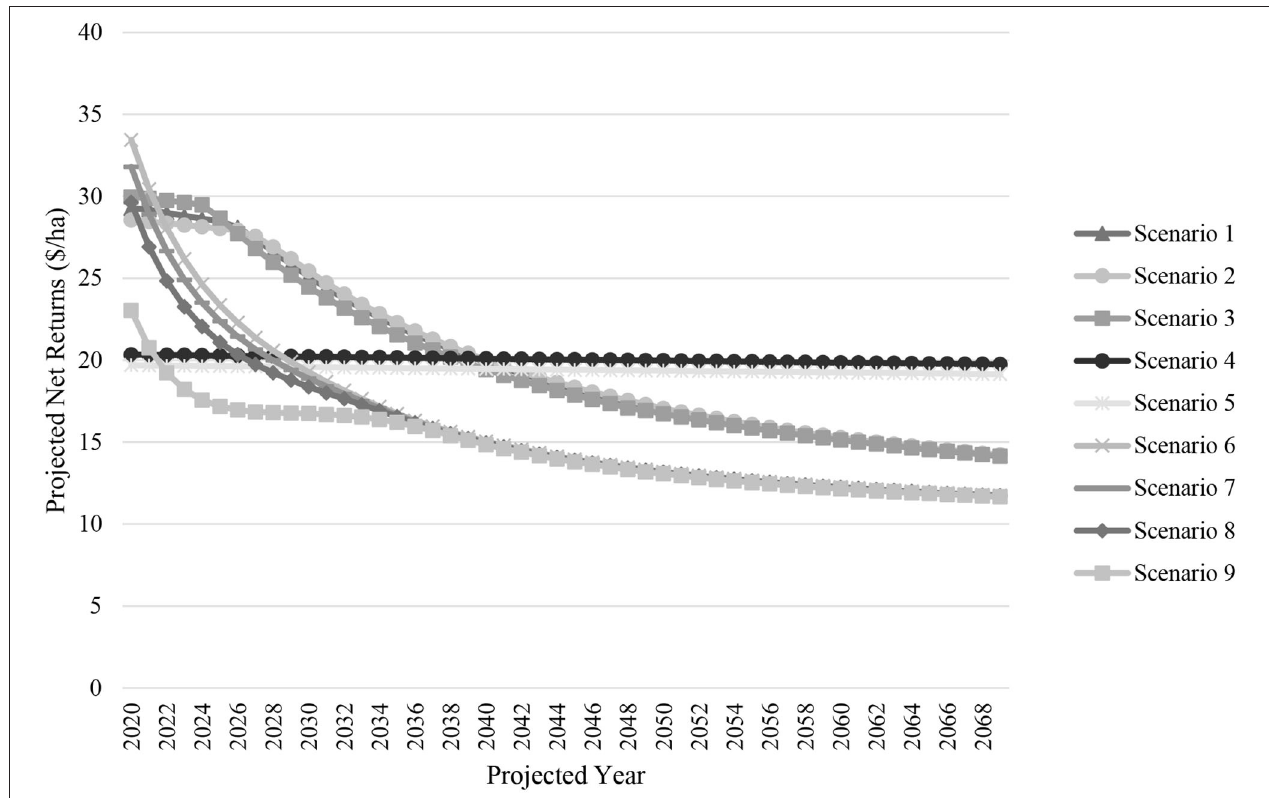
FIGURE 5 | Projected net returns ($ ha − 1 ) across nine field-level scenarios for a representative farm in Hale County,